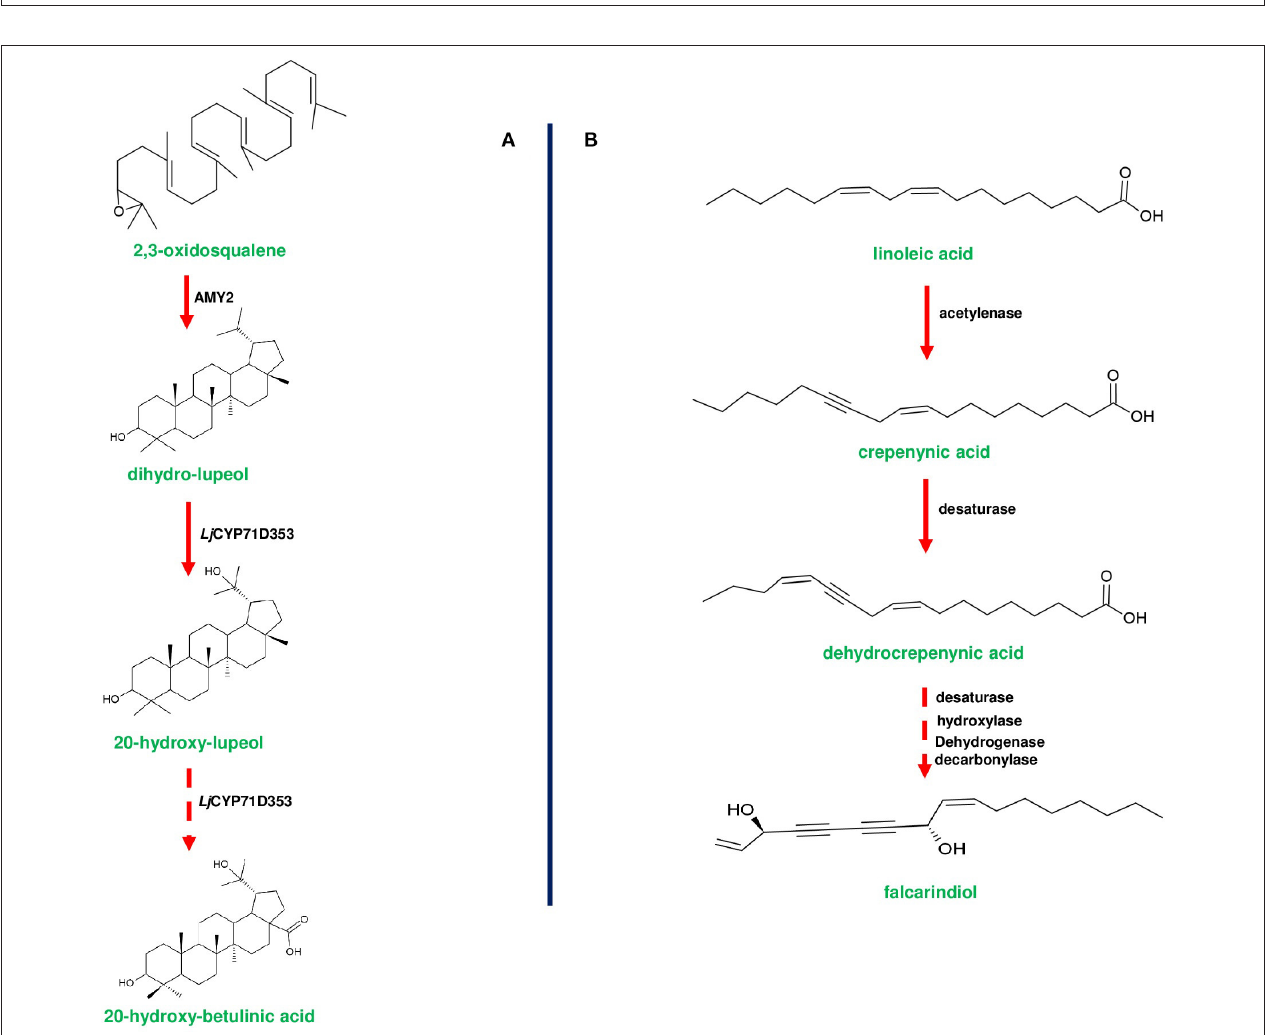
FIGURE 6 | Biosynthetic pathways of 20-hydroxy-betulinic acid in Lotus japoinucs and anti-pathogenic fatty acid falcarindiol in tomato. (A) shows the biosynthesis of 20-hydroxybetulinic acid from 2,3-oxdiosqaulene by the enzymes encoded by a triterpene producing gene cluster in Lotus japonicus. AMY2 ( β -amyrin synthase) converts 2,3-oxidosqualene into a unique metabolite dihydro-lupeol. Subsequently dihydro-lupeol is converted to 20-hydroxy-betulinic acid by two consecutive reactions catalyzed by L. japonicus CYP71D353. (B) represents the bioproduction of falcarindiol from the primary metabolite linoleic acid by the enzymes of anti-pathogenic fatty acid gene cluster in S. lycopersicum (tomato). Linoleic acid is converted to crepenyic acid by acetylenase enzyme encoded by Solyc12g100240 gene. Crepenyic acid is converted into dehydrocrepenyic acid by a desaturase (Solyc12g100250). Subsequently, dehydrocrepenyic acid is converted to falcarindiol by a set of desaturase, hydroxylase, and decarboxylase. Dotted arrows represent a multi-step pathway. for producing defense compounds such as glucosinolates and camalexin (Halkier et al., 2002; Takos et al., 2011). Similarly, GAME7 encoding CYP72 class CYP450 modifies cholesterol